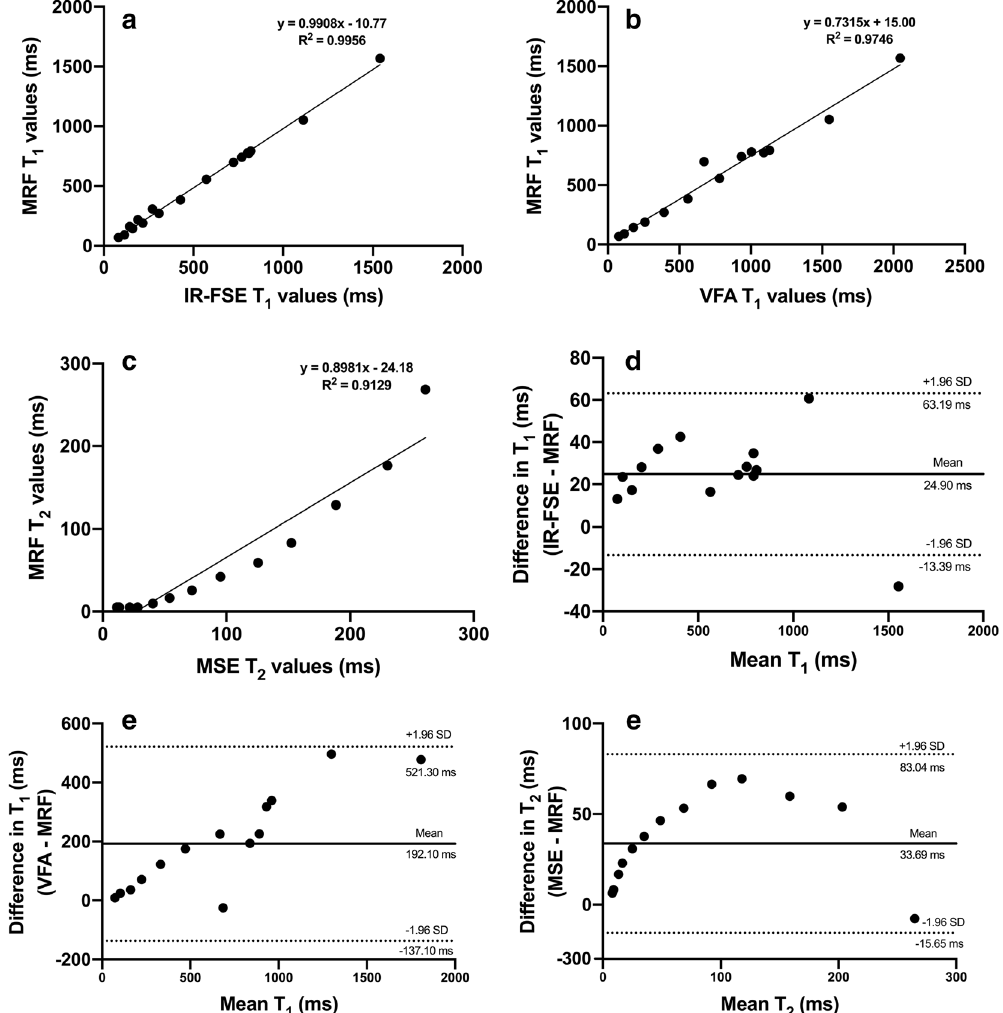
Figure 1. Linear regression plots ( a – c ) and Bland–Altman plots ( d – f ) comparing MRF T 1 values with those obtained using IR-FSE ( a , d ) and VFA ( b , e ) mapping techniques and MRF T 2 values with those obtained using MSE technique ( c , f ). Figures ( a – c ) include captions representing slopes of the linear fits, y-intercepts and coefficients of determination (R2). On figures ( d – f ), dotted lines represent upper and lower 95% limits of agreement and bold lines represent the mean biases with appropriate captions included. MRF magnetic resonance fingerprinting, IR-FSE inversion recovery fast spin echo, VFA variable flip angle, MSE multiple spin echo, SD standard deviation.